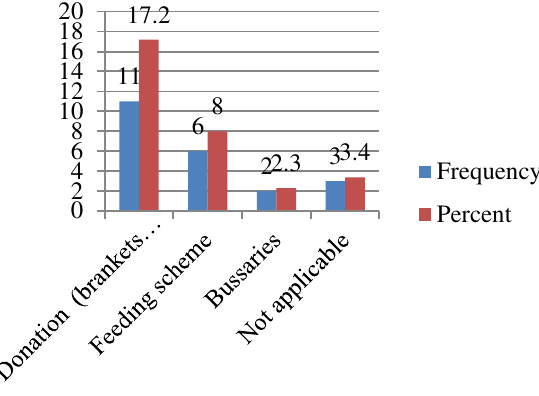
Fig. 14. Give any view on how your business engages in community